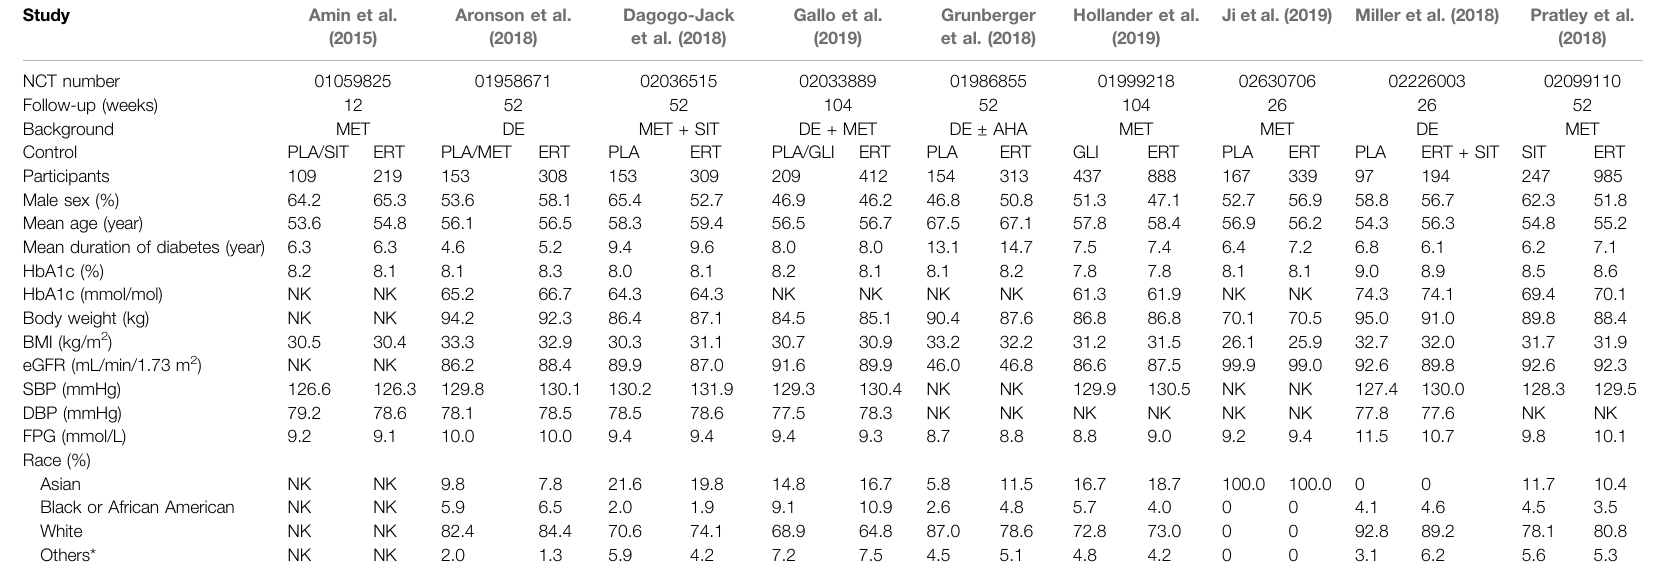
Ji et al. (2019) Miller et al. (2018) Pratley et al.